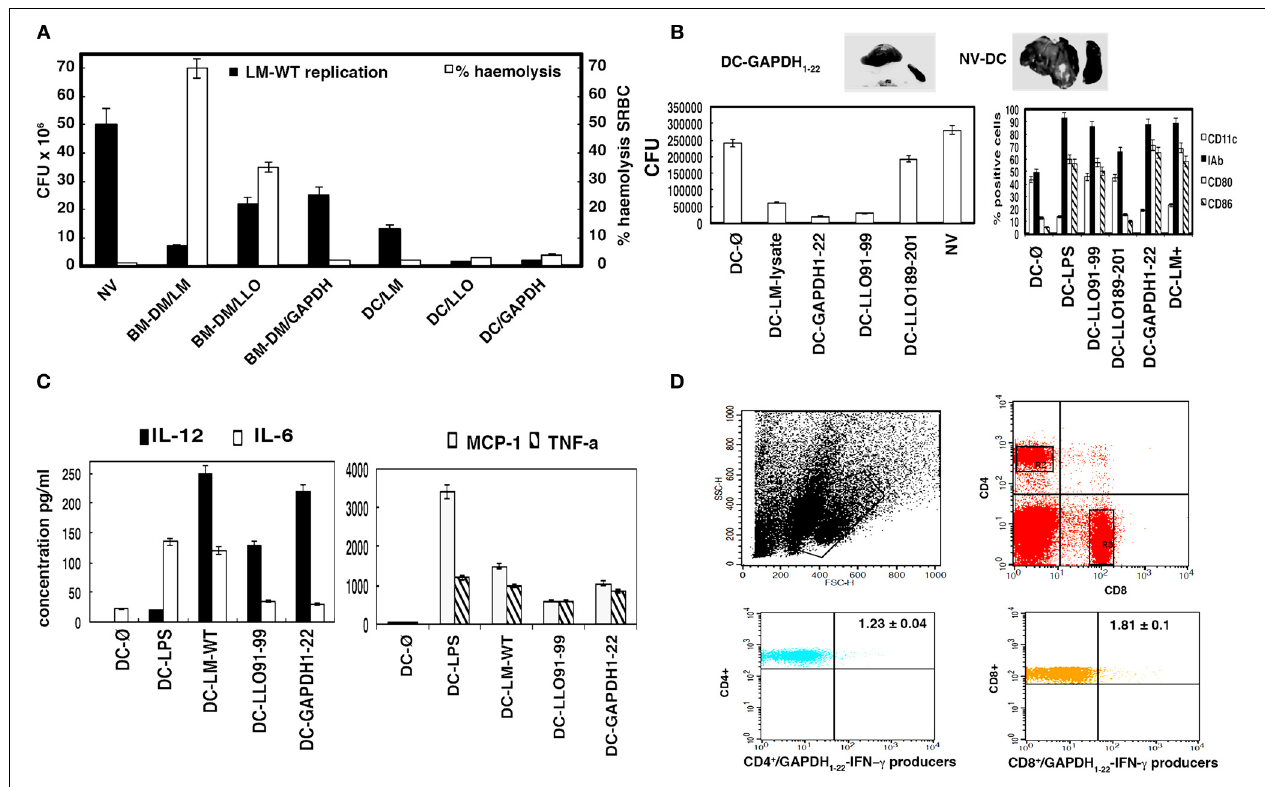
FIGURE 3 | Comparison of different BMDM and DC vaccine vectors for protection against listeriosis. (A) C57BL/6 mice were vaccinated i.p. or not (NV) for 7 days with different BMDM or DC vaccine vectors (BMDM-LM-WT, BMDM-LLO, BMDC-LM-WT, BMDC-LLO, and BMDC-GAPDH) (1 × 10 6 cells) ( n = 5 mice/vaccine vector) and challenged i.p. with 5 × 10 3 CFU LM-WT for 3 days. Results of spleens homogenates are mean ± SD of three different experiments ( P < 0 . 01) (black bars in figure and left scale legend). Same vaccine vectors were incubated in vitro with SRBC (0.5% solution). Hemolytic units were defined as the dilution of the sample that caused 50% hemoglobin release from 200ml of 0.5% SRBC. Controls were established for 0% hemolysis using empty DCs and for 100% hemolysis by incubating SRBC with distilled water. (B) C57BL/6 mice were vaccinated i.p. or not with empty DCs (DC-Ø) or with saline (NV) using the